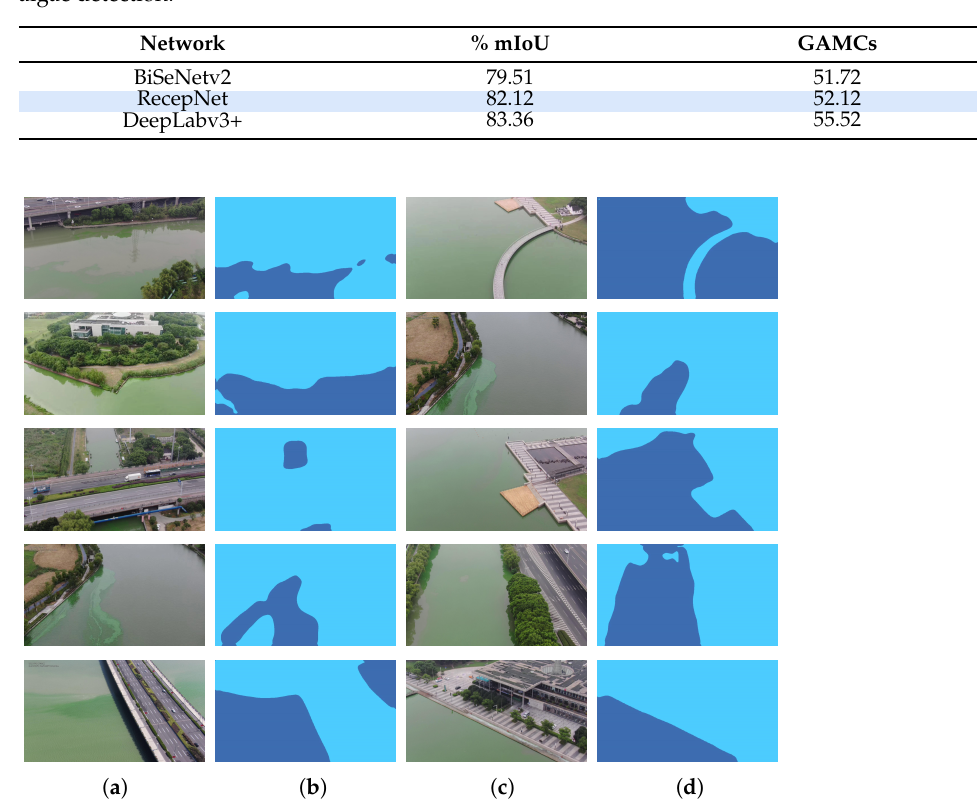
Table 12. Comparison of RecepNet, BiSeNetv2 and DeepLabv3+’s performance on blue-green algae detection.